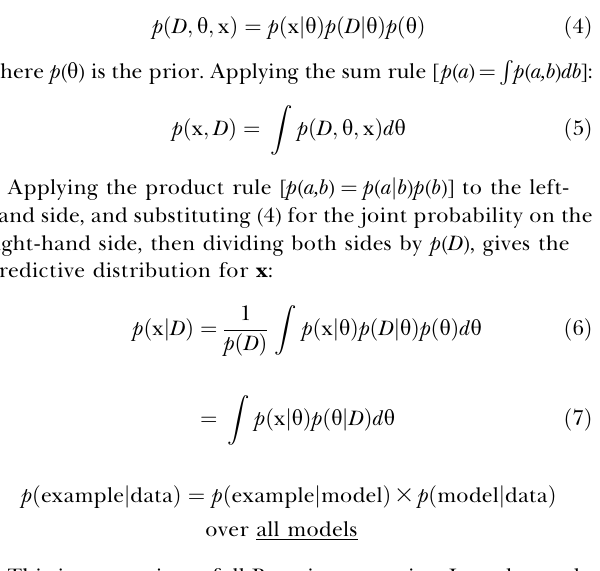
probability distribution over the parameters. The parameters are considered to be latent variables, and the key idea is to marginalise over these unknown parameters, rather than to make point estimates. This is known as marginal likelihood.